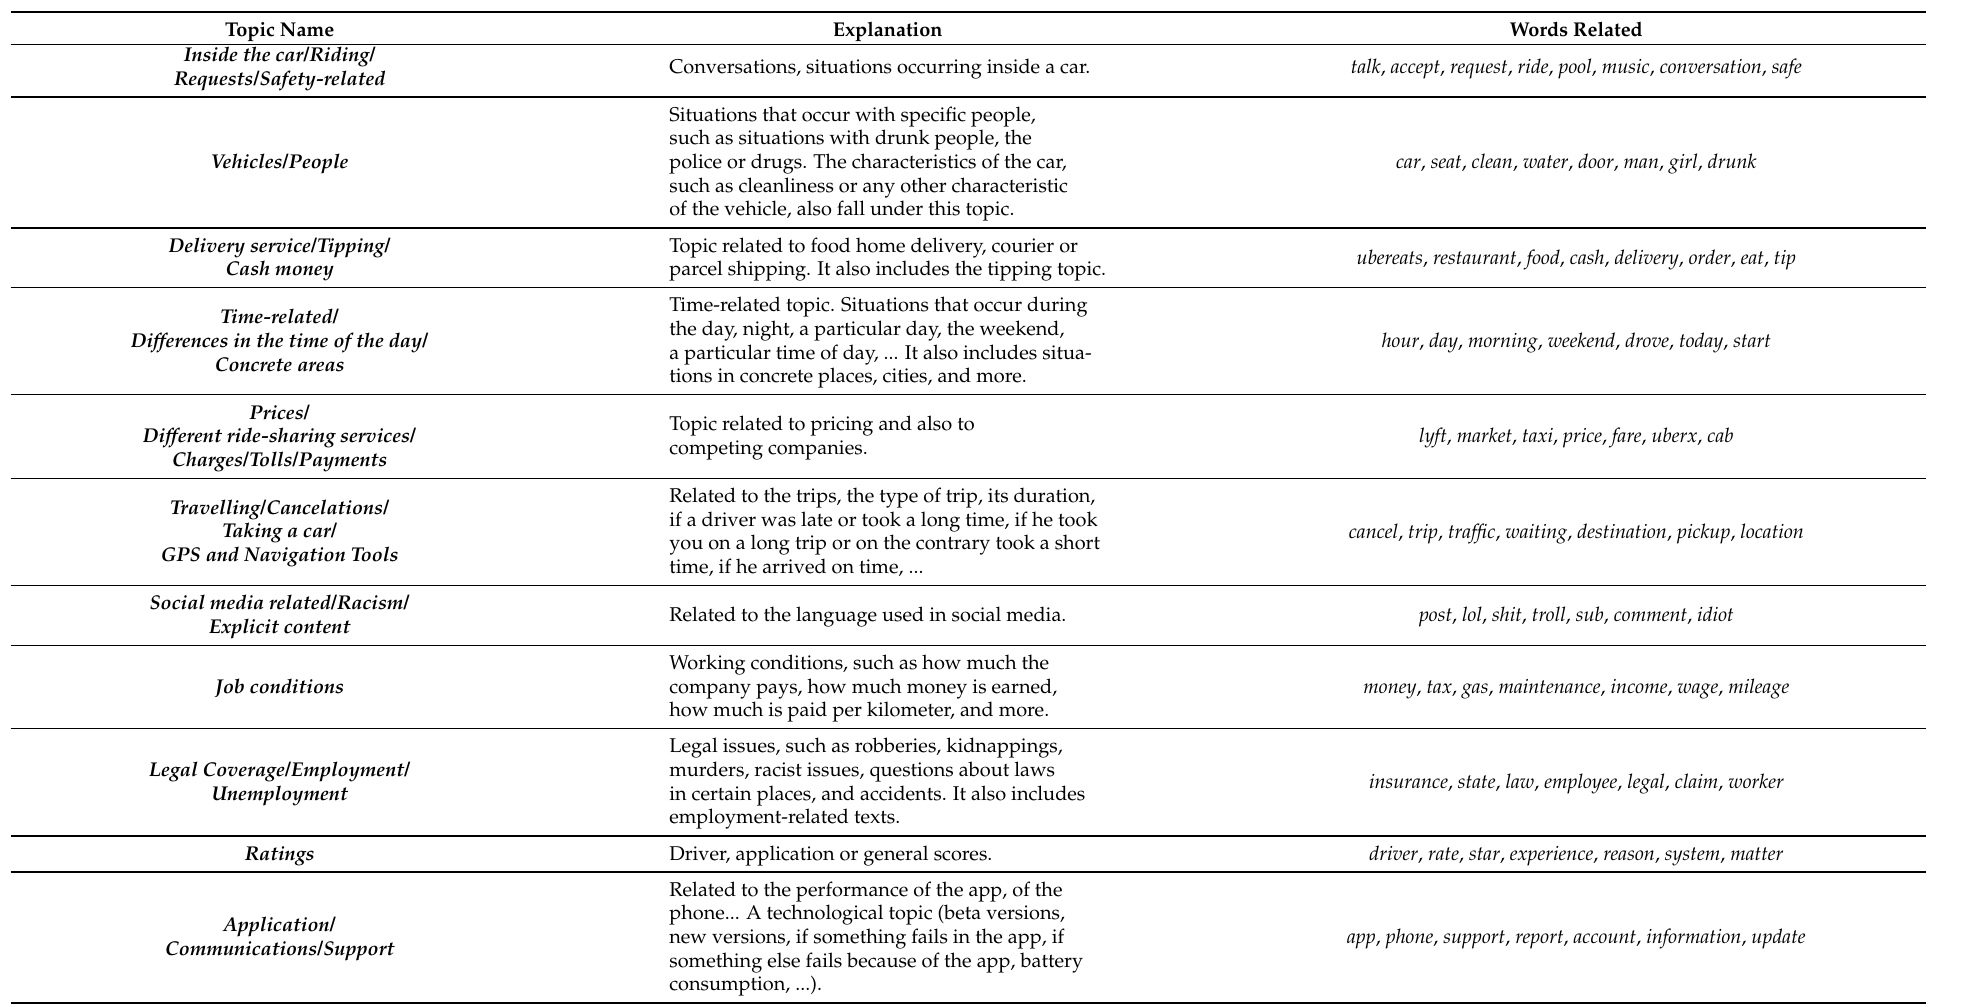
Table 3. Explanation of each extracted topic, including titles, definitions, and the most common words for each